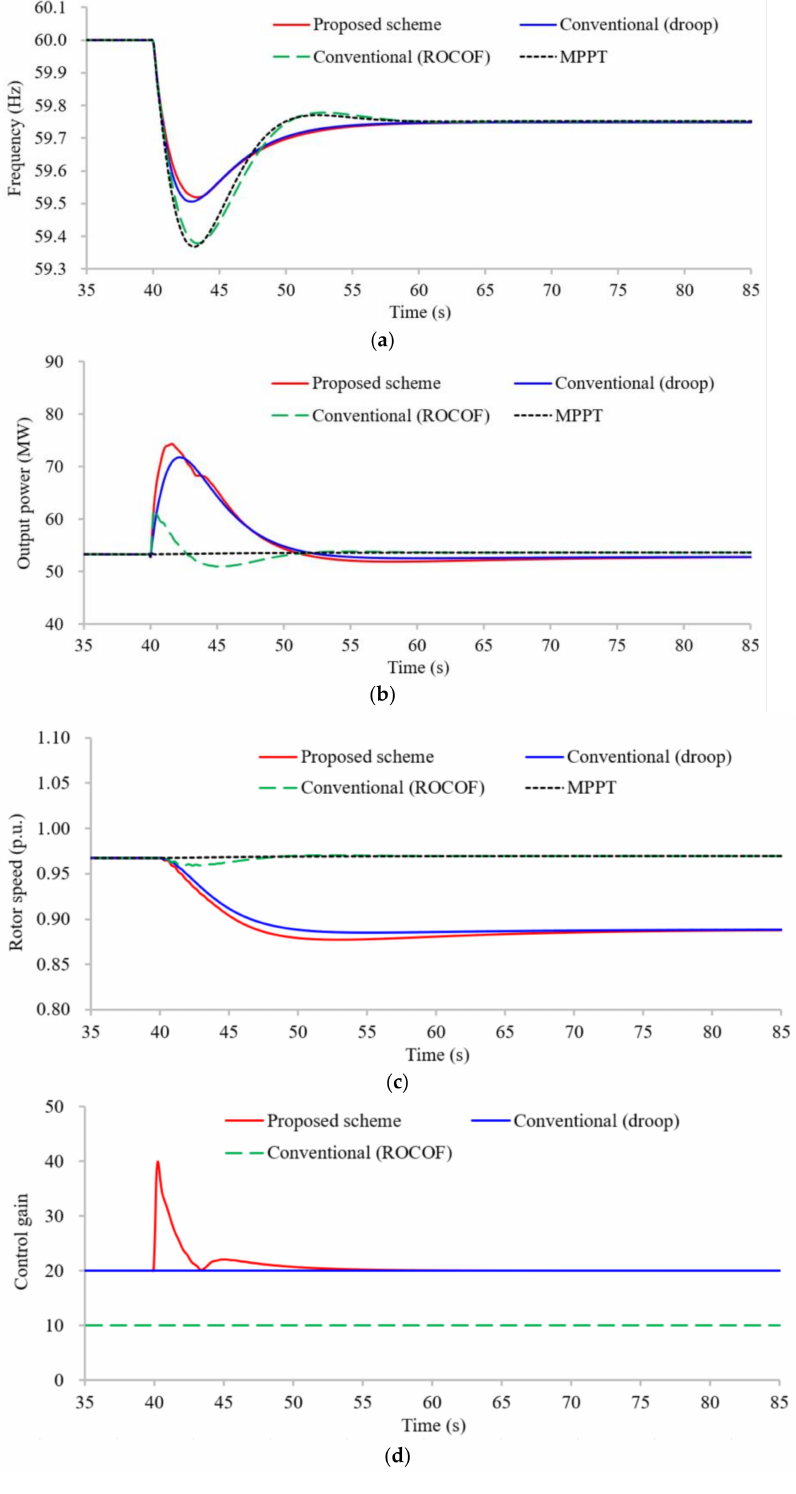
Figure 7. Simulation results for Case 2: ( a ) System frequencies; ( b ) Active power of the DFIG; ( c ) Rotor speeds; ( d ) Control